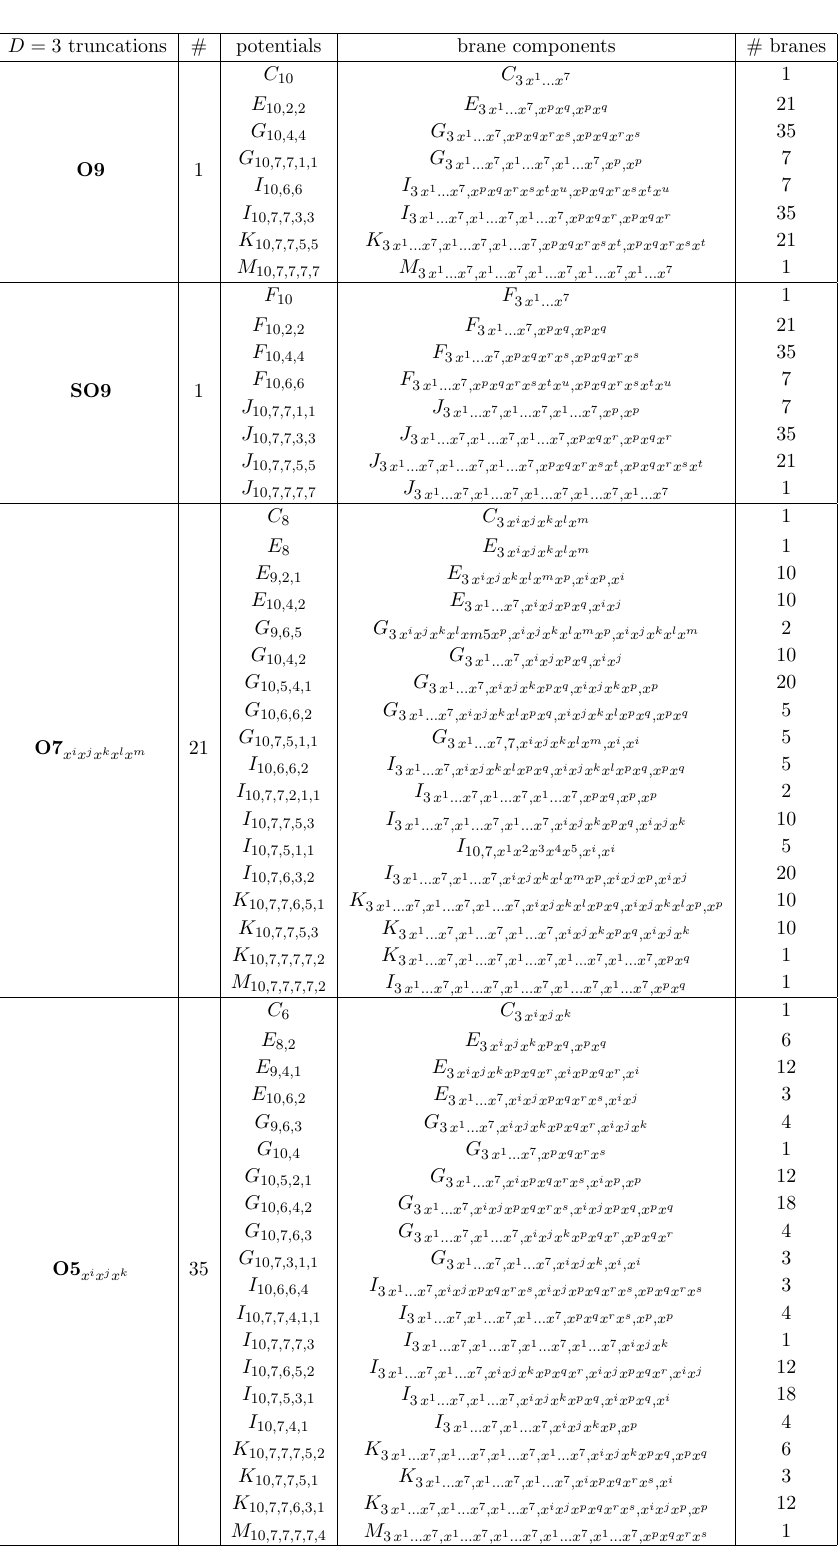
Table 10 . (Part 1 of 2) The Z 2 truncations of the maximal theory in D =